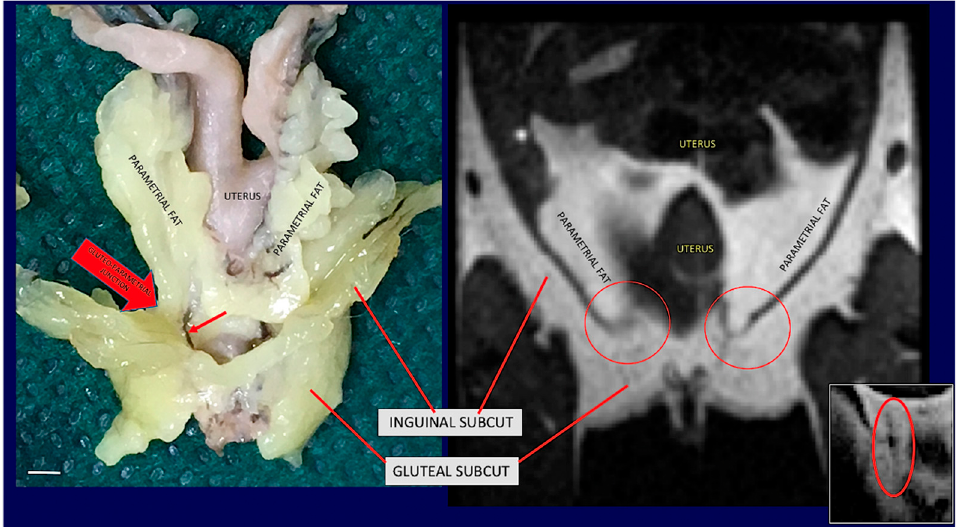
Figure 3. Gross anatomy and MRI of subcuteous-visceral continuity in the lower part of mouse Adipose Organ. ( Left ): Anatomical preparation of an adult C57BL/6 mouse showing subcutaneous-visceral continuity between parametrial and gluteal fat. ( Right ): coronal T1-weighted MRI of the same areas shown in the left panel of the same animal in vivo. Anatomical continuity is indicated in the visceral (parametrial) and subcutaneous (inguinal) fat by arrow and red circles. A small red arrow on the left panel shows a vessel in the junction. A similar structure was also detected by MRI (red circled area in small, squared panel on the right). Bar 4.5 mm in both panels.